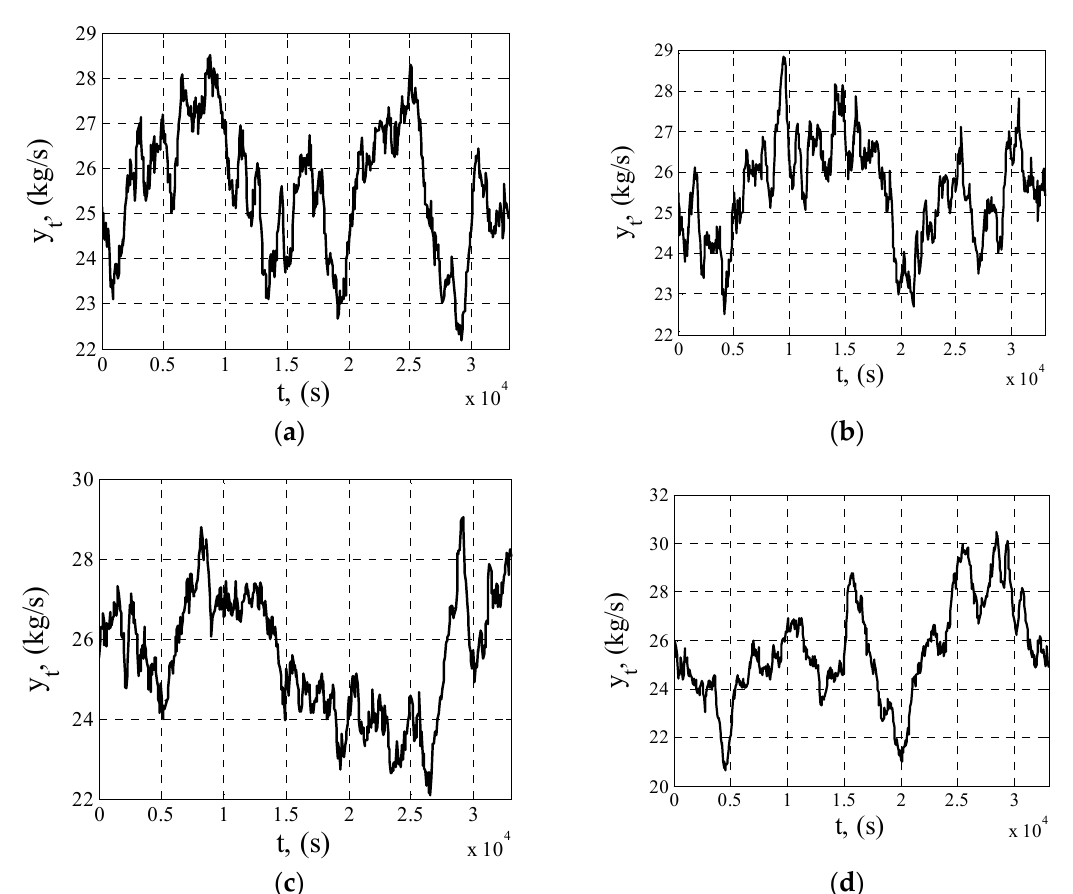
Figure 9. Examples of simulated feed solids flow rates: ( a ) series 1, ( b ) series 4, ( c ) series 8, ( d ) series 10. Table 4. Identification results of solids flow models into the feed determined from 10 simulated time courses. Model